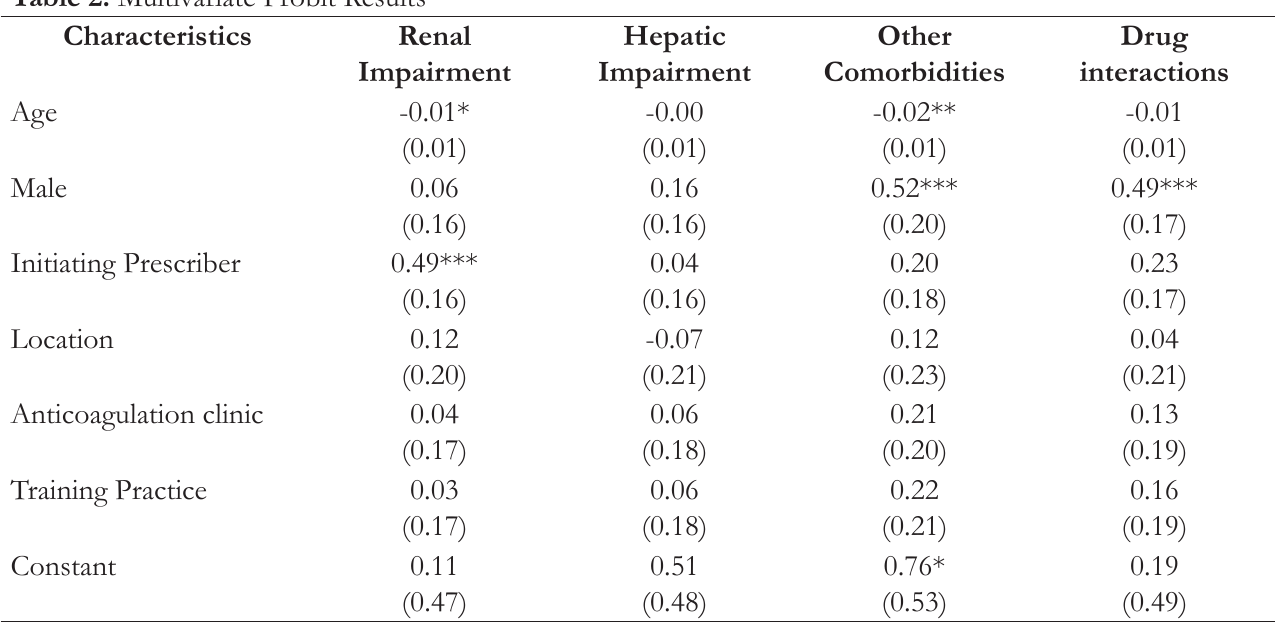
Table 2. Multivariate Probit